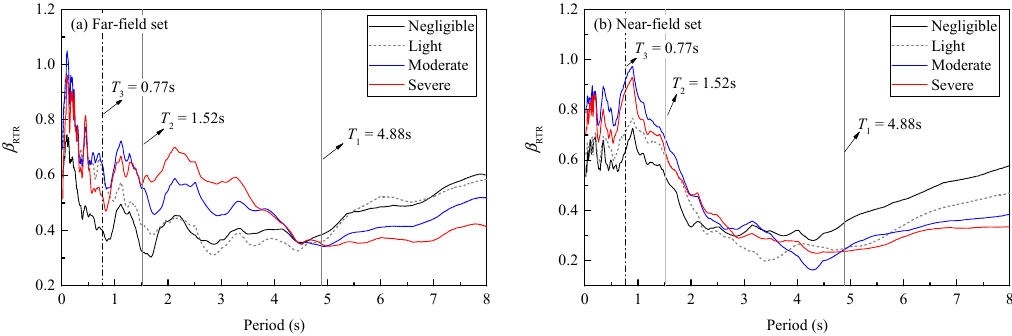
Figure 11. Dispersion between θ max and spectral acceleration corresponding to arbitrary periods.